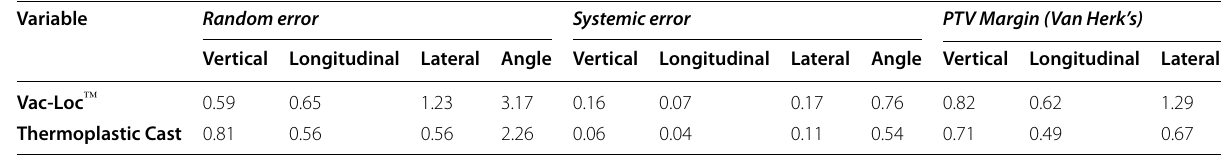
Random errors, systemic errors and PTV margins measured in cm. Angular rotation random and systemic errors measured in Degree